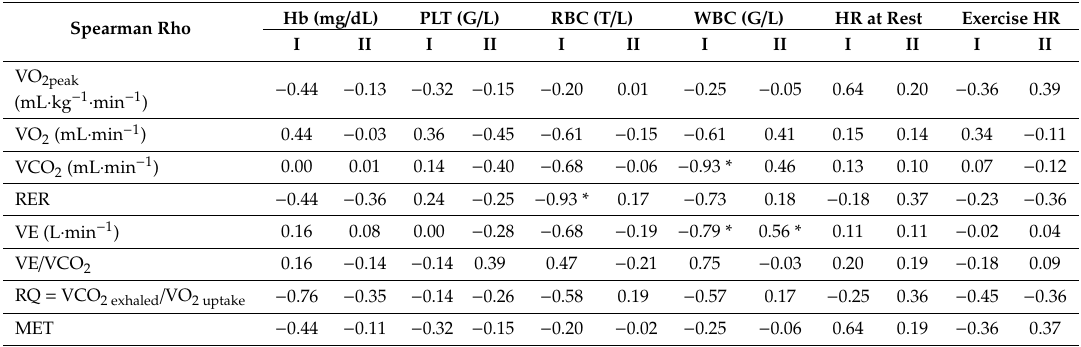
Table 8. Correlation between the exercise stress test results and blood count parameters and heart rate with the division into age groups (7–10 and 11–13 years). Values of p < 0.05 were considered statistically significant. Hb (mg / dL) PLT (G / L) RBC (T / L) WBC (G / L) HR at Rest Exercise Spearman Rho